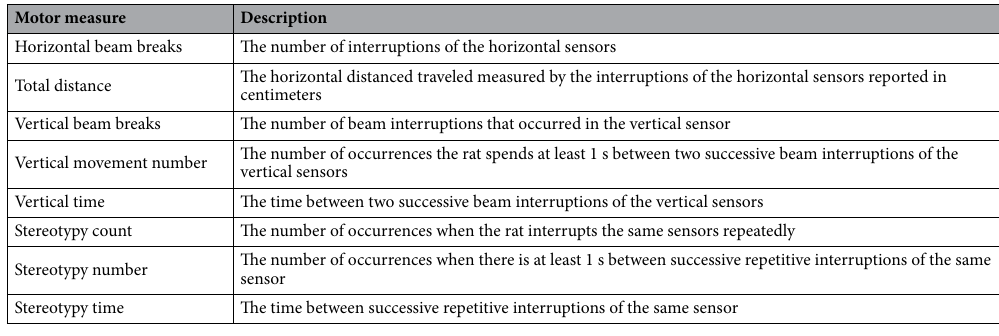
Table 1. Descriptions of parameters utilized for motoric